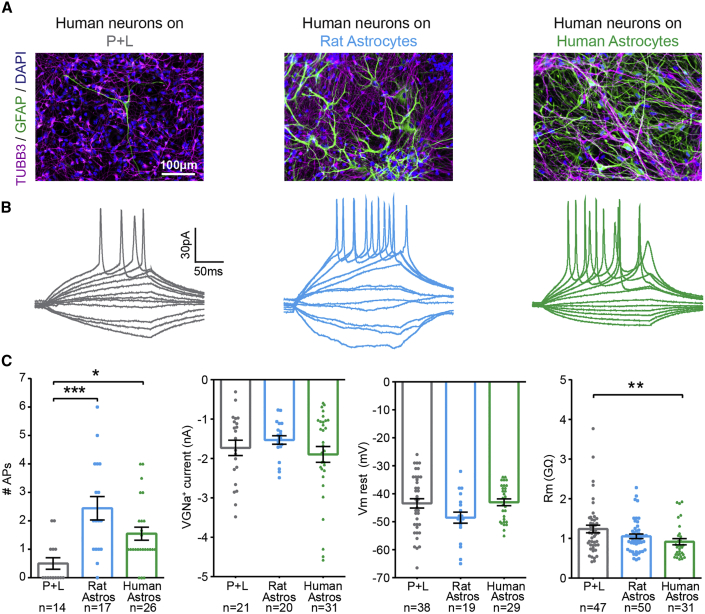
Co-culture with iPSC-Astrocytes Enhances Cortical iPSC-Neuron Excitability(A) Example immunofluorescence images of human iPSC-neurons grown in three different culture conditions: on polyornithine and laminin-coated coverslips (P + L, neurons 127 days; left), as co-cultures with rat astrocytes (neurons 79 days, co-cultured for 36 days; middle), or as co-cultures with human iPSC-astrocytes (neurons 88 days, astrocytes 117 days, co-cultured for 47 days; right).(B) Example action potentials evoked in response to square current steps across the three culture conditions.(C) Population data on the number of action potentials, amplitude of peak VGNa+ currents, resting membrane potential (Vm rest), and membrane resistance (Rm) across the three culture conditions. Sample sizes represent individual neurons recorded from 13 cultures across three cell lines (P + L neurons: 92 ± 3.3 days), 12 cultures across two cell lines (on rat astrocytes: neurons 93 ± 4.9 days, co-cultured for 51 ± 2.9 days), and five cultures across two cell lines (on human astrocytes: neurons 84 ± 7.6 days, astrocytes 120 ± 9.5 days, co-cultured for 44 ± 7.7 days). ∗p < 0.05, ∗∗p < 0.01, ∗∗∗p < 0.001.